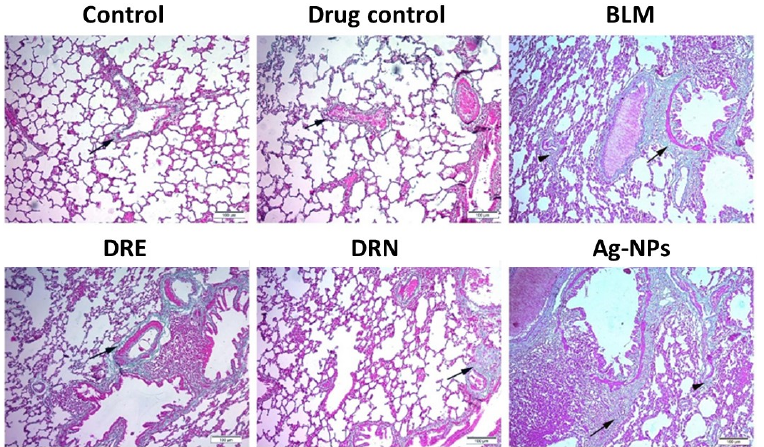
Figure 3. Effect of DRE and DRN on collagen deposition in the lungs of BLM male Swiss albino rats (Masson Trichrome × 100; image resolution 300 DPI).